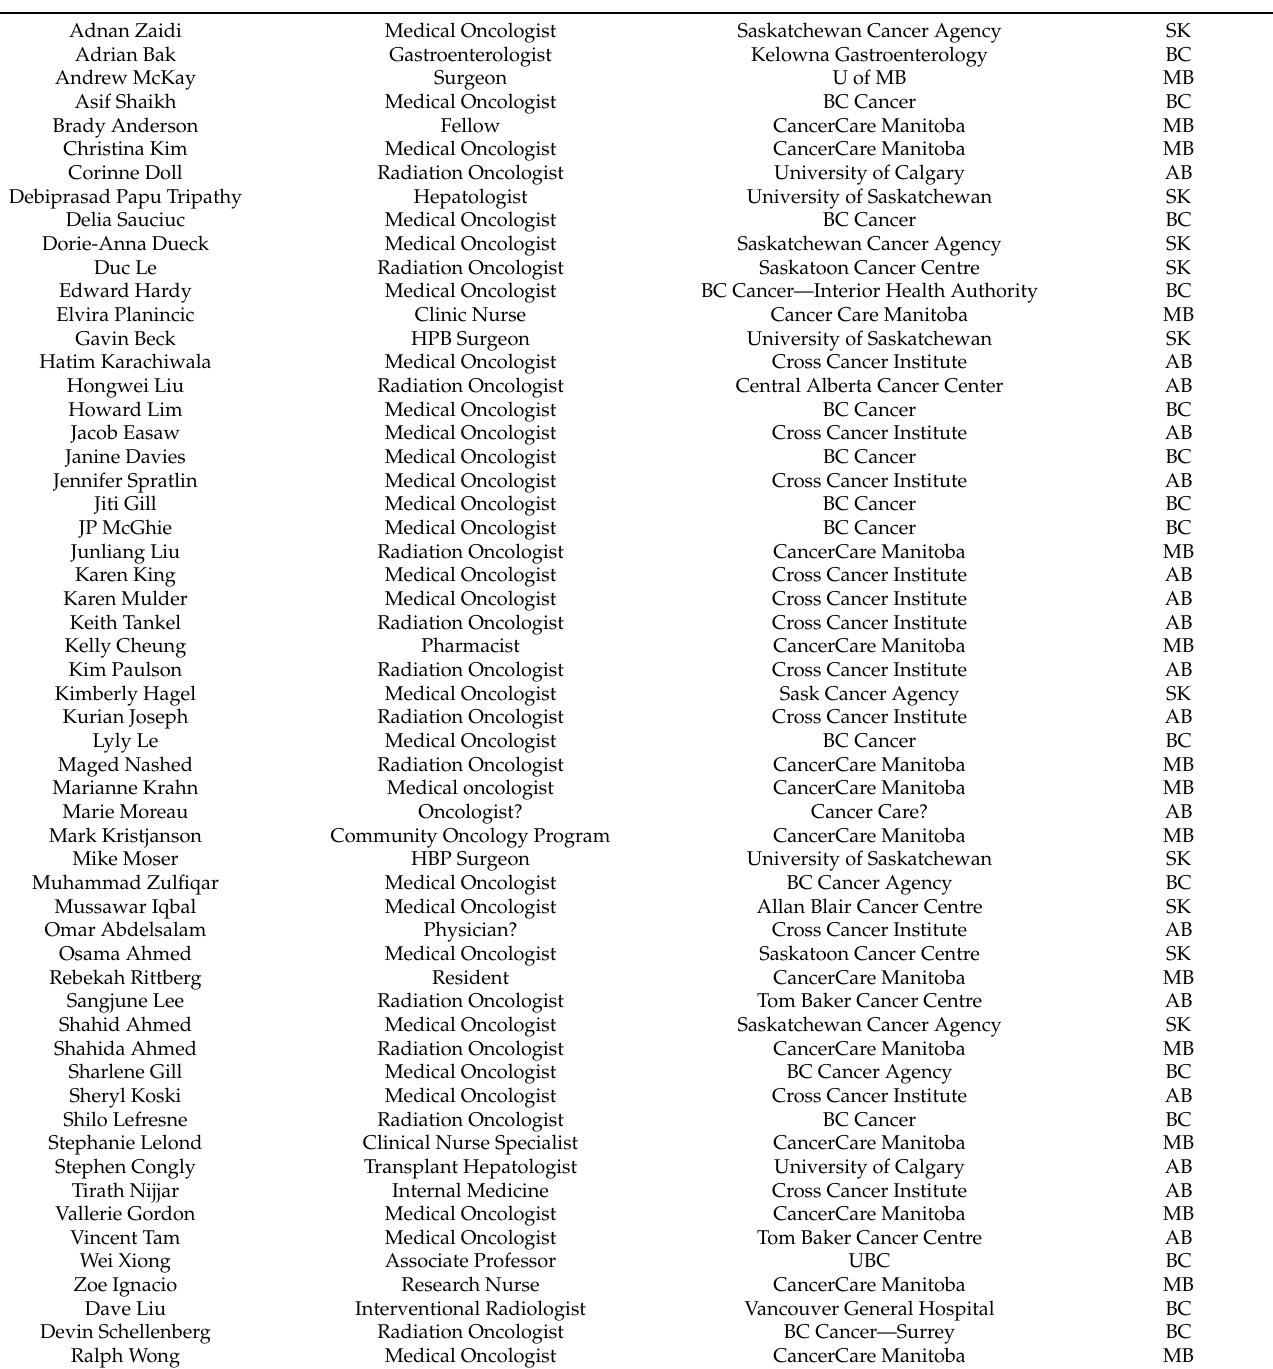
The Western Canadian Gastrointestinal Cancer Consensus Conference welcomes medical oncologists, radiation oncologists, surgical oncologists, pathologists, radiologists, gastroenterologists, and allied health professionals from Western Canada who are involved in the care of patients with gastrointestinal malignancies (Table